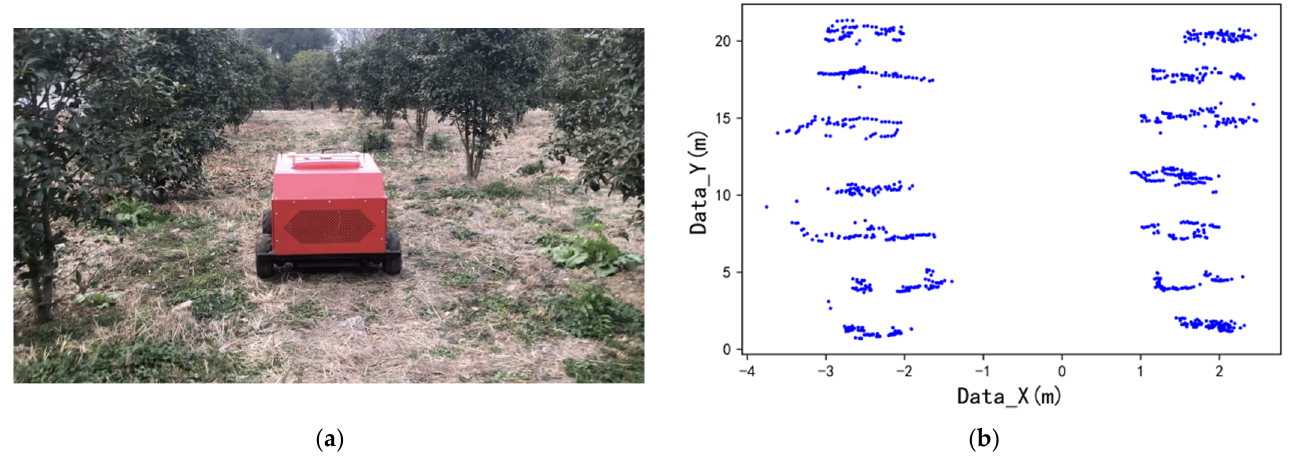
Figure 8. Complete fruit tree row point cloud data. ( a ) Fruit trees on both sides of the test platform in the actual scene; ( b ) point cloud data corresponding to fruit trees on both sides of the test platform.